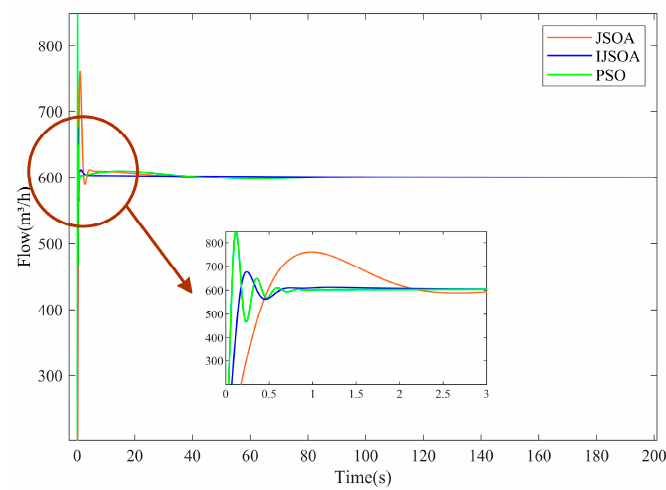
Figure 9. Comparison of flow control effect.